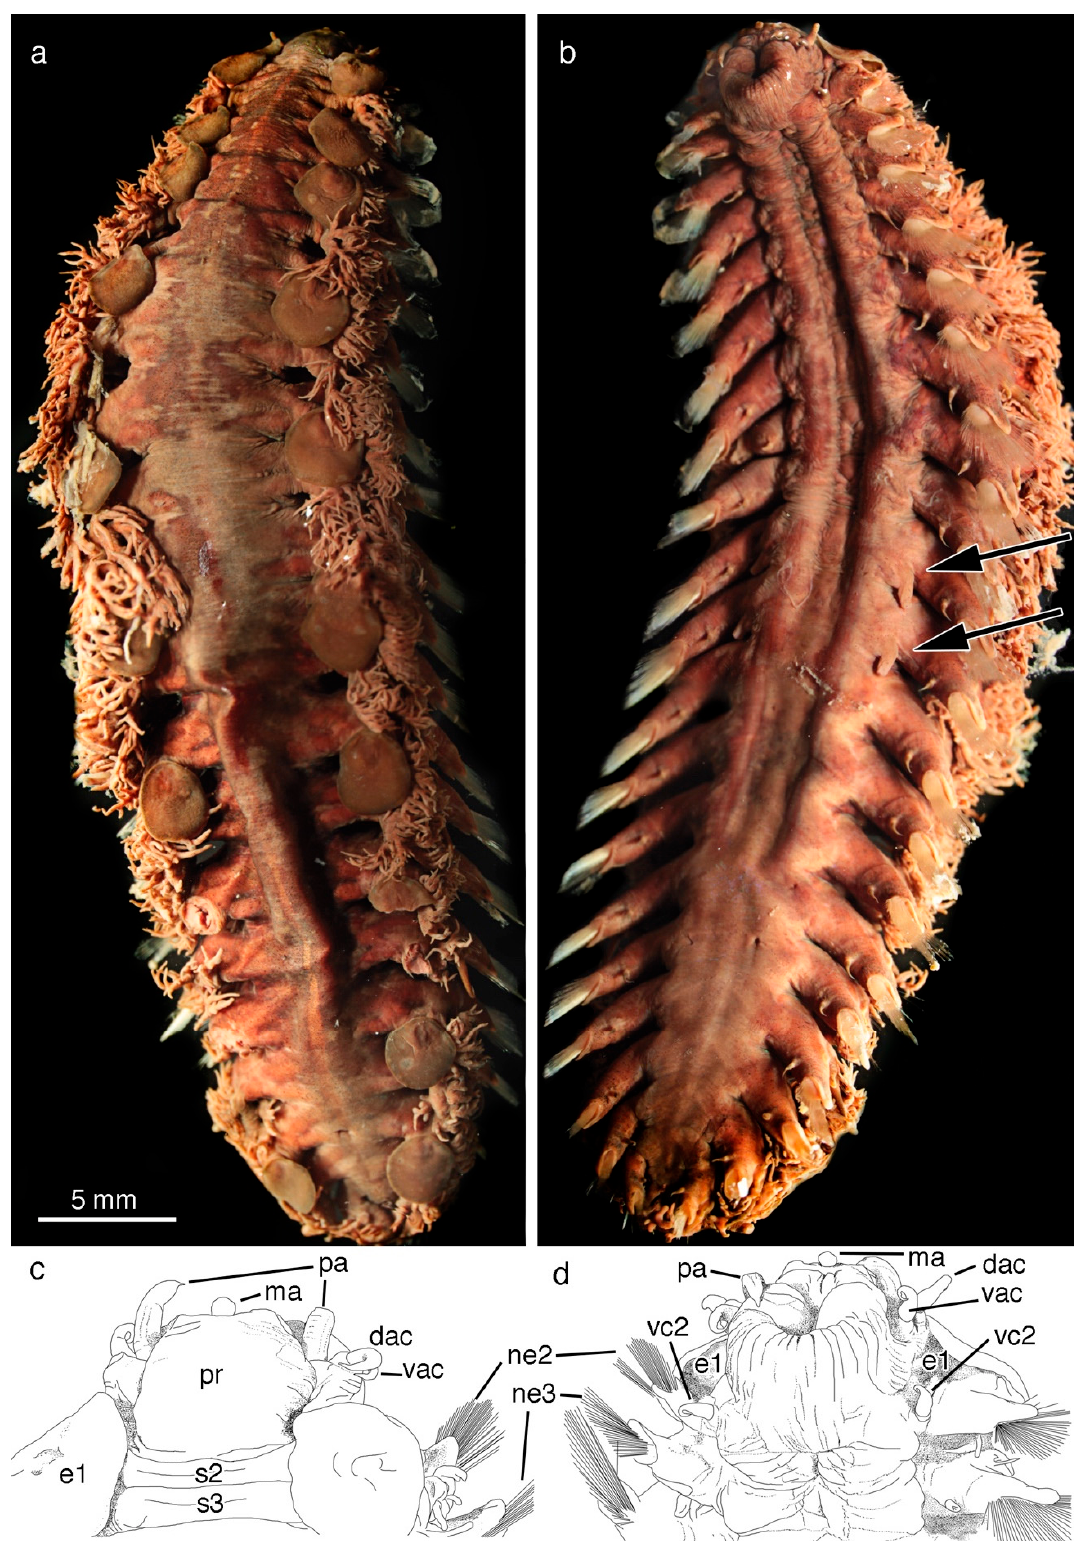
Figure 7. Branchipolynoe eliseae n. sp. female holotype (SIO-BIC A6660) ( a ). Dorsal view. ( b ). Ventral view. Arrows indicate elongated ventral papillae of Segments 11 and 12. ( c ). Drawing of dorsal anterior. ( d ). Drawing of ventral anterior. Abbreviations: pa, palps; ma, median antenna; pr, prostomium; e1, first elytron (attached on Segment 2); s2 and s3, Segments 2 and 3; dac, dorsal anterior cirrus; vac, ventral anterior cirrus; ne2 and ne3, neuropodia 2 and 3; vc2, ventral cirrus on Segment 2.